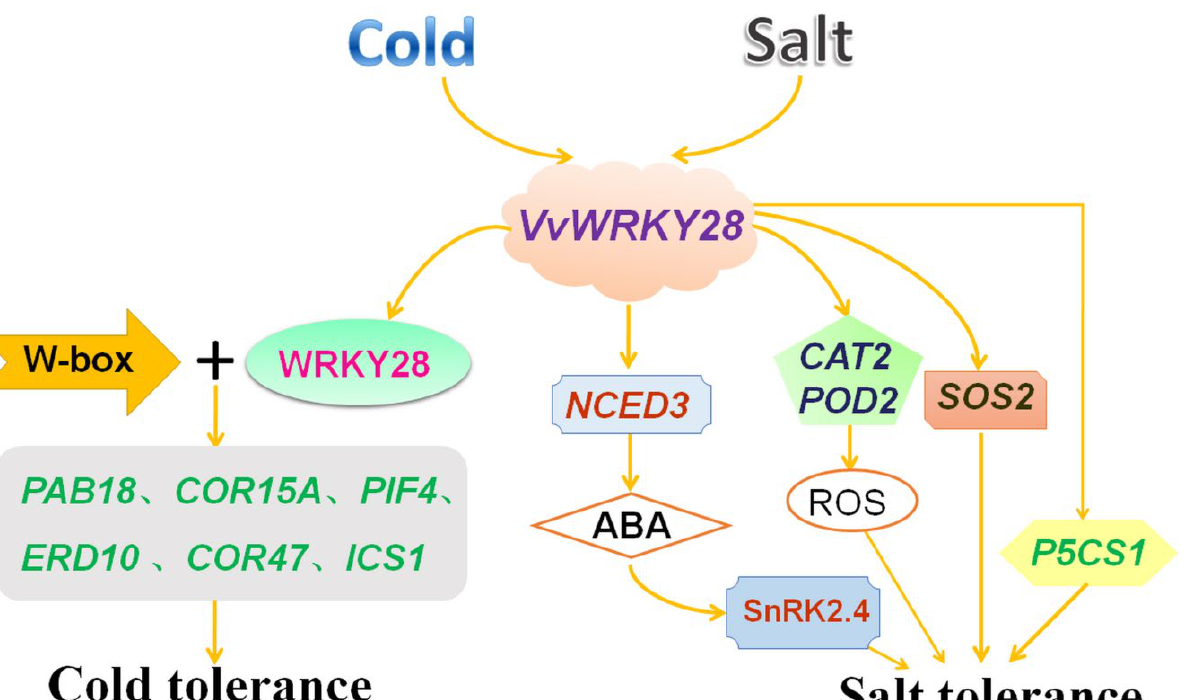
Figure 10. A possible model of VvWRKY28 in response to salt stress. VvWRKY28 was overexpressed after cold stress, binded to the W-box on the promoter of downstream target genes, and up-regulated the expression of RAB18 , COR15A , ERD10 , PIF4 , COR47 , and ICS1 . Secondly, salt stress induces high-level expression of VvWRKY28 , activates ABA signaling pathway and salt stress response process, and promotes the expression of NCED3 and SnRK2.4 in the ABA-dependent pathway. The expression levels of CAT2 , SOD1 , and SOS2 and ABA-independent P5CS1 genes increased significantly.